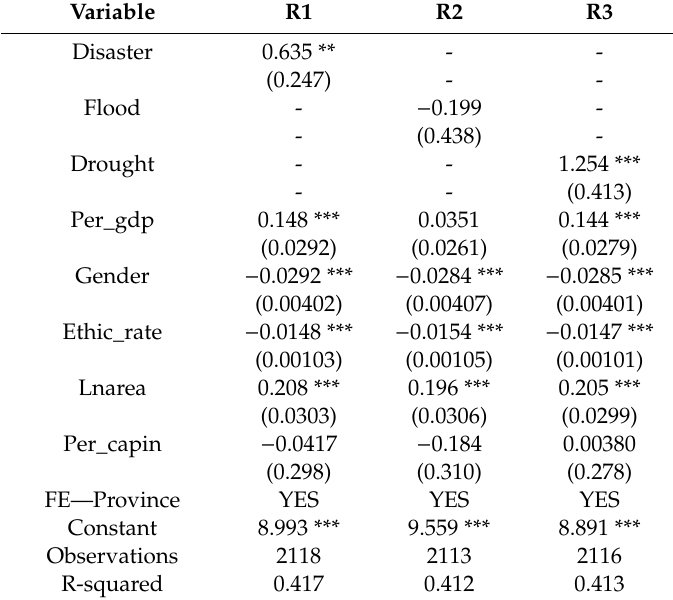
Table 5. Impact of 500 years (1950–2000) of disaster frequency on contemporary human capital, OLS estimates